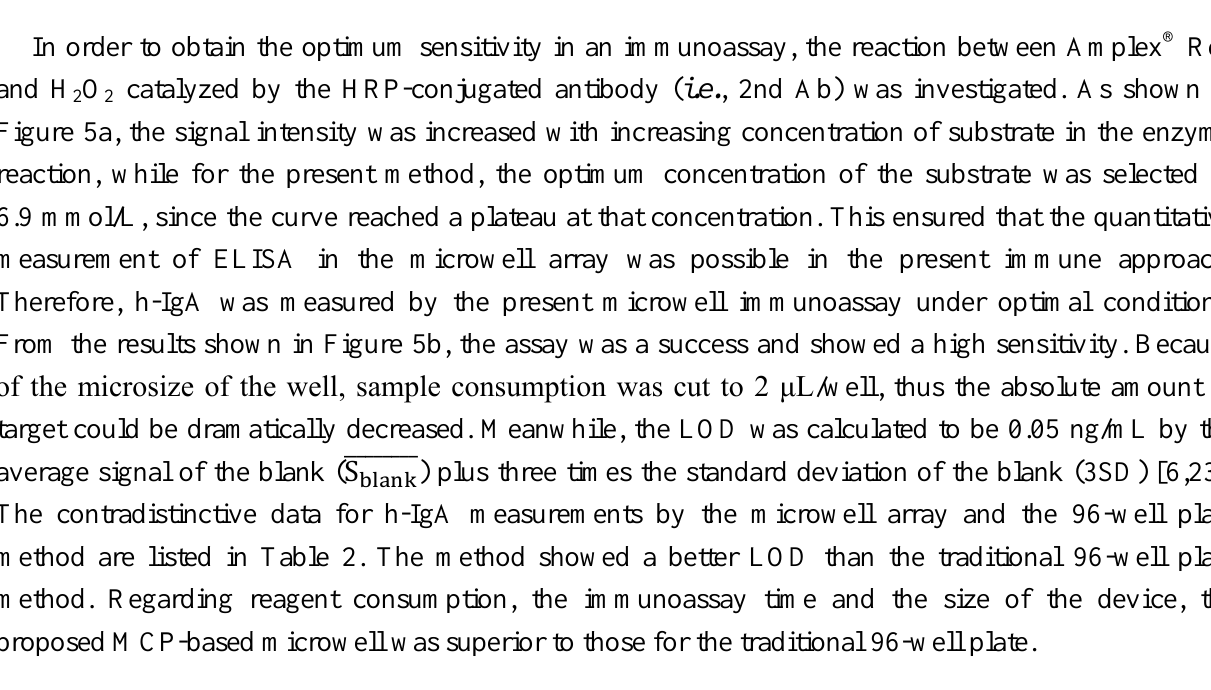
Table 2. Comparison of the ELISA performance in the present microwell array and 96-well